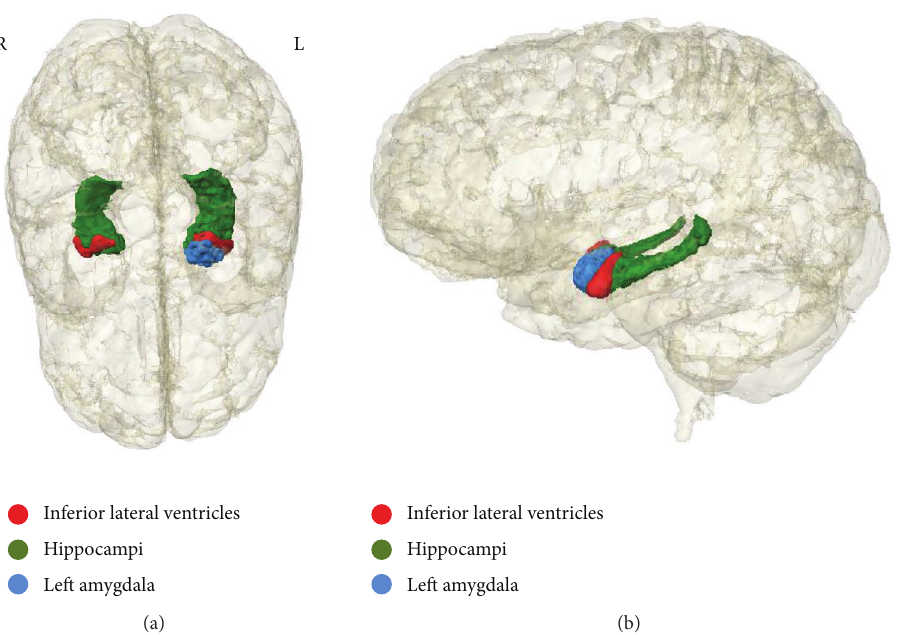
Figure 1: Representation of the top 5 significant subcortical volumes based on raw data in Table 6. (a) Superior view (b) Lateral view.